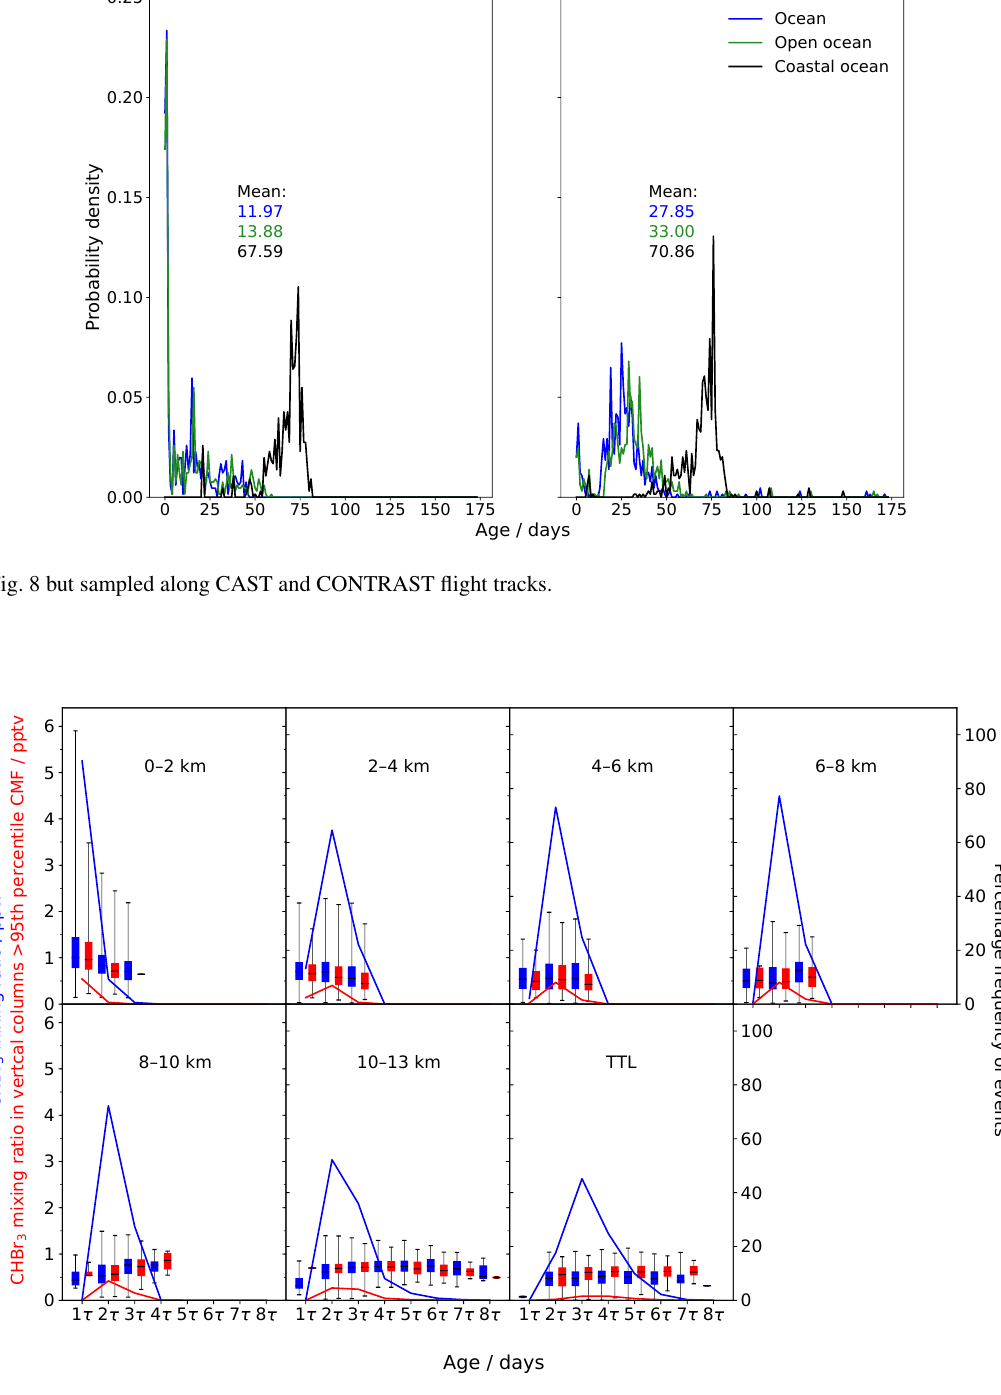
Figure 10. Box-and-whiskers plot of model CHBr 3 mole fractions from the entire ocean tracer as a function of 2km altitude intervals and a nominal 24-day e -folding lifetime ( τ ). Data are averaged over 18 January–28 February 2014 and over 10 ◦ S–30 ◦ N, 125–175 ◦ E. Blue values correspond to results determined by all available data, and red values correspond to results determined by convective mass fluxes > 95th percentile. Solid lines denote the percentage of occurrence rate over the period and region denoted above. Percentage of occurrence rate refers to how often air masses fall within the specified age